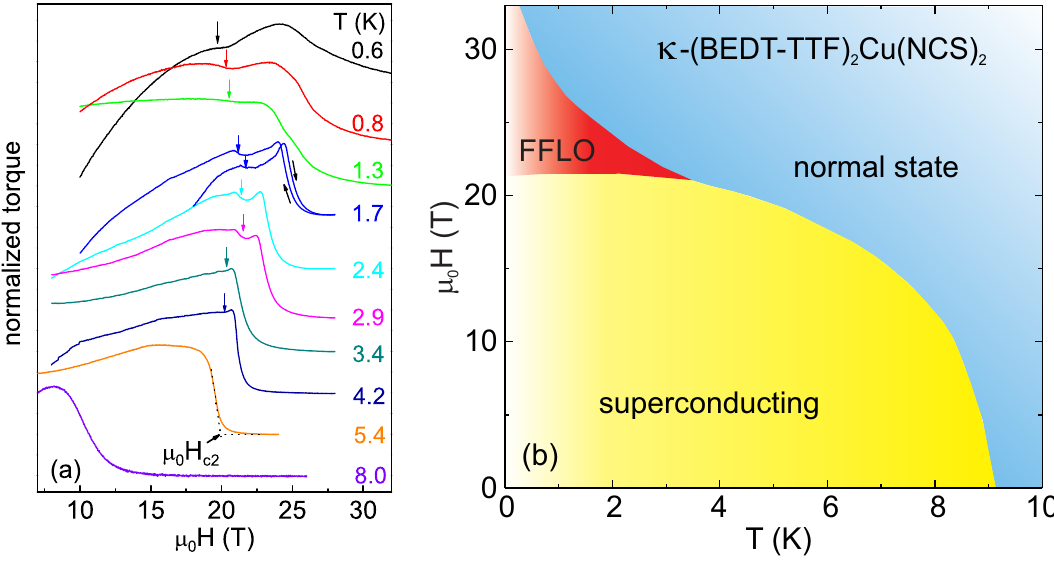
Figure 5. ( a ) Magnetic-torque data of (cid:20) -(BEDT-TTF) for in-plane magnetic fields aligned along the b direction. For T = 1 : 7 K, data for both up and down field sweeps, otherwise only down sweeps are shown. The vertical arrows mark the small dip-like features, which are associated with the transition into the FFLO state; ( b ) Schematic phase diagram deduced from the data shown in ( a )